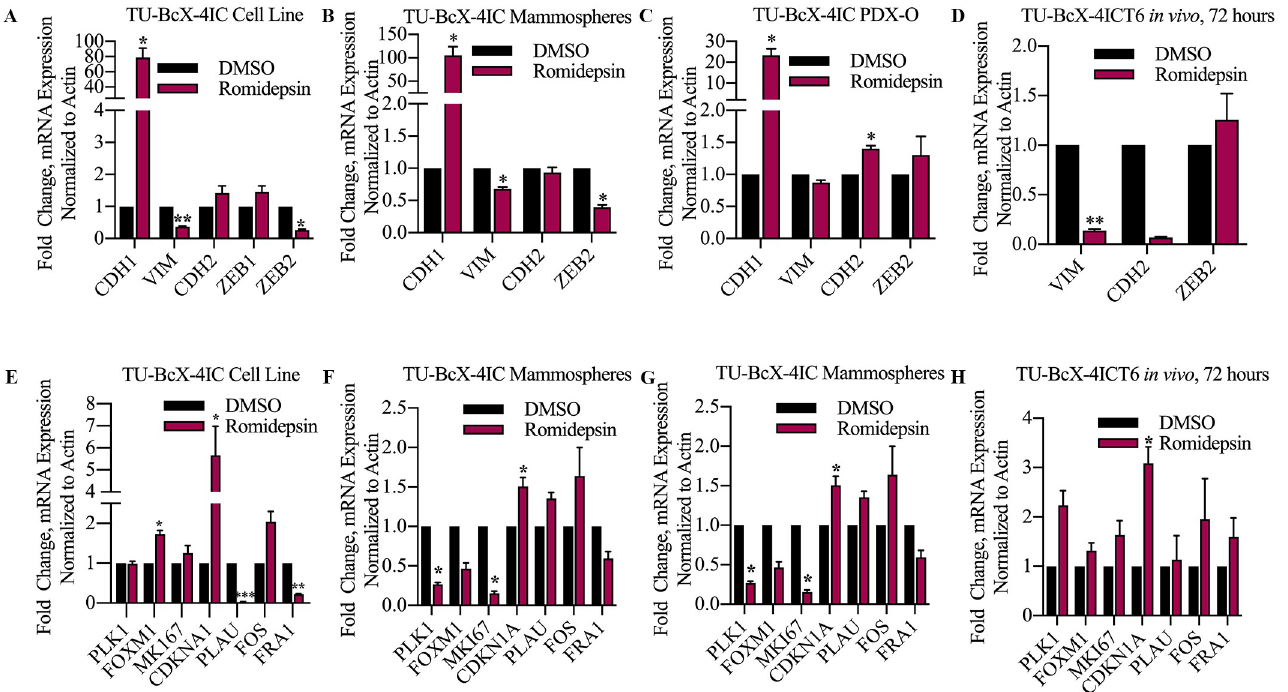
Fig 5. Effects of romidepsin on gene expression differs amongst treated cells, spheres, PDX-Os, and implanted tumors. Romidepsin treatment in TU-BcX- 4IC (A) cell line, (B) spheres, (C) PDX-Os, and (D) in vivo tumor pieces implanted in SCID/Beige mice. qRT-PCR analysis was repeated with genes affected by romidepsin treatment compared to DMSO control based on RNA sequencing analyses ( PLK1 , FOXM1 , MKI67 , CDKN1A , PLAU , FOS , FRA1 ). Again, romidepsin-treated TU-BcX-4IC (E) cells, (F) spheres, (G) PDX-Os, and (H) in vivo tumor pieces implanted in mice were used. Analyses were all normalized to β -actin and DMSO treated controls. Black bars represent DMSO; maroon bars represent romidepsin treatment (100 nM, 72 hours). � p < 0.05, �� p < 0.01, ��� p < 0.001.